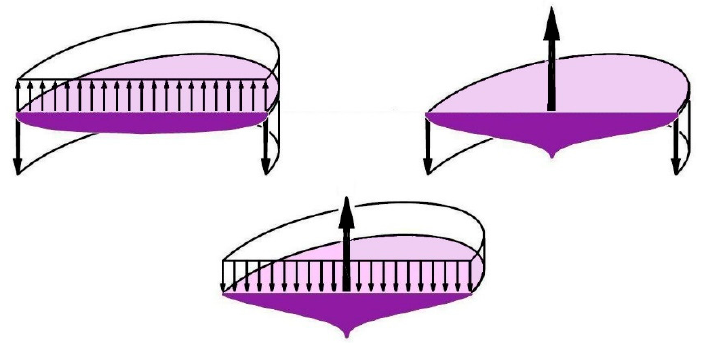
Figure 1. VCMs derived from the VTD class leading to a cycloid-like form and two tulip-like forms. The three dimensionless thicknesses T 20 , with ρ = r / a , ρ ∈ [0, 1] (Lemaitre [2]), are as follows: top left: cycloid-like VCM with uniform loading and reaction at the edge, T 20 = (1 − ρ 2 ) 1/3 ; top right : tulip-like VCM with axial force at center and edge reaction, T 20 = ( − ln ρ 2 ) 1/3 ; down : tulip-like VCM with uniform loading and central reaction, T 20 = ( ρ 2 − ln ρ 2 − 1) 1/3 .